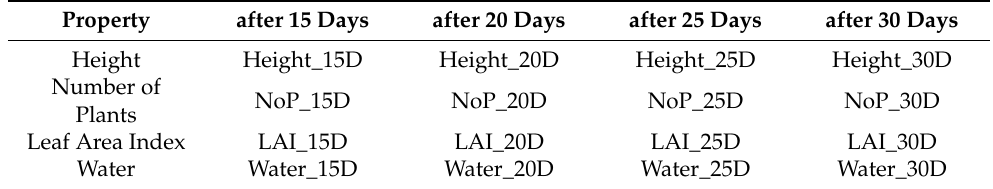
Table 4. Responses analyzed through DoE.